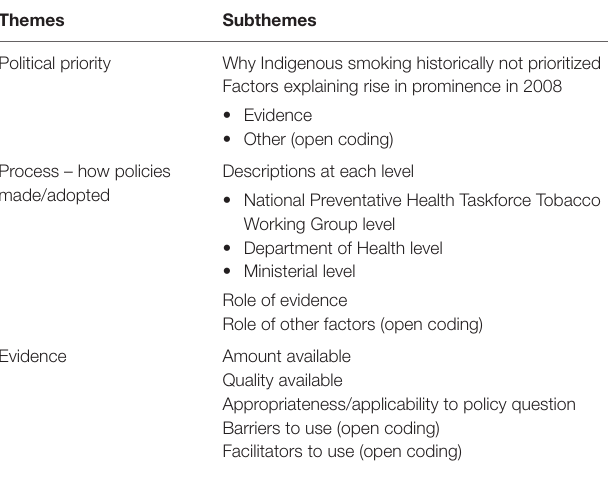
TaBle 2 | Themes and subthemes coded for data